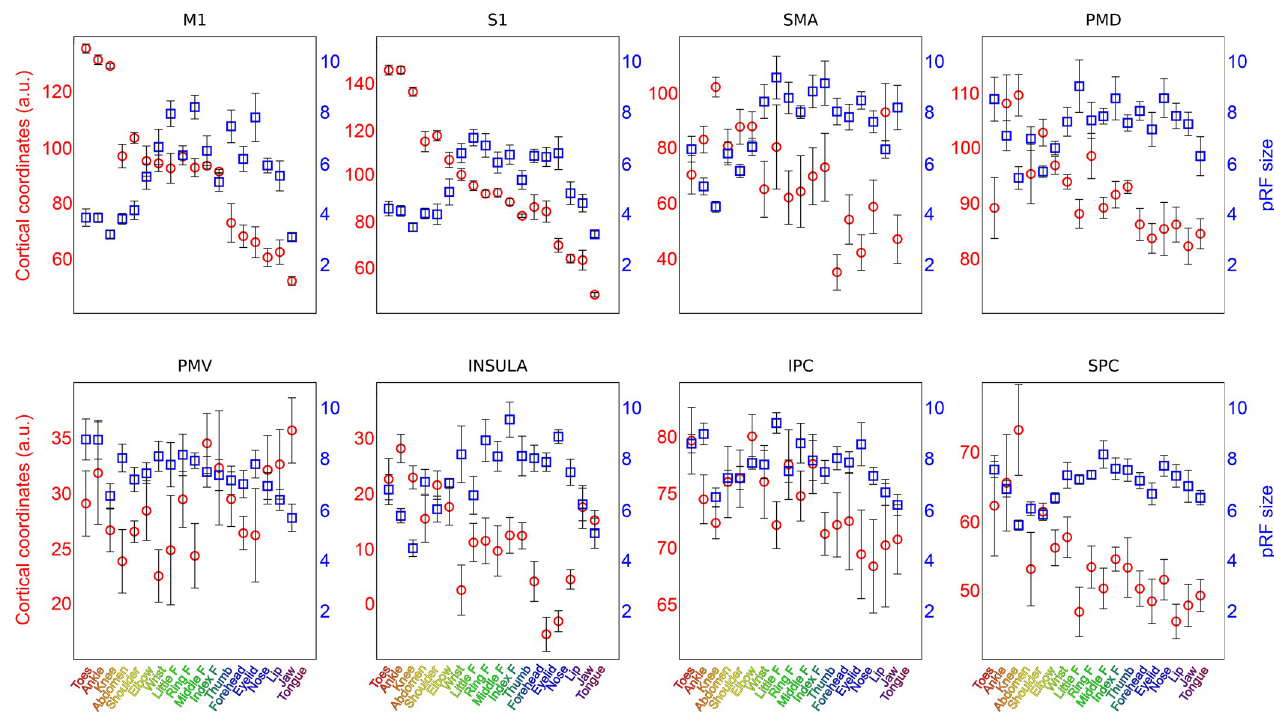
Fig 5. pRF size and cortical coordinates per pRF center. For each ROI the mean cortical coordinates (red circles) and mean pRF size (blue squares) are plotted versus the estimated pRF centers (horizontal axis). Both the depicted coordinates and pRF size values were calculated as the mean value across neuronal populations with the same pRF center (horizontal axis). Error bars denote the S.E.M. across subjects.